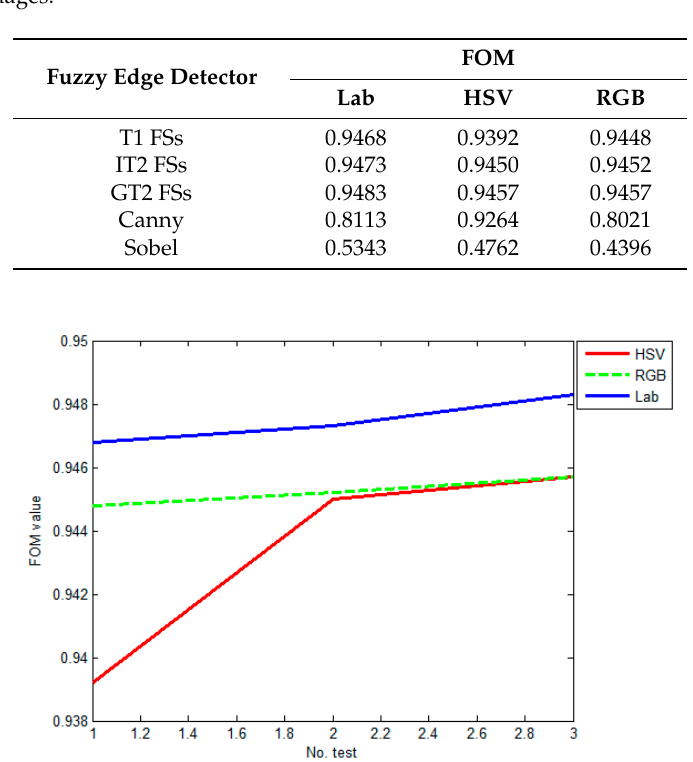
Figure 7. FOM values achieved by the fuzzy edge detectors in Lab, HSV, and RGB color format images.